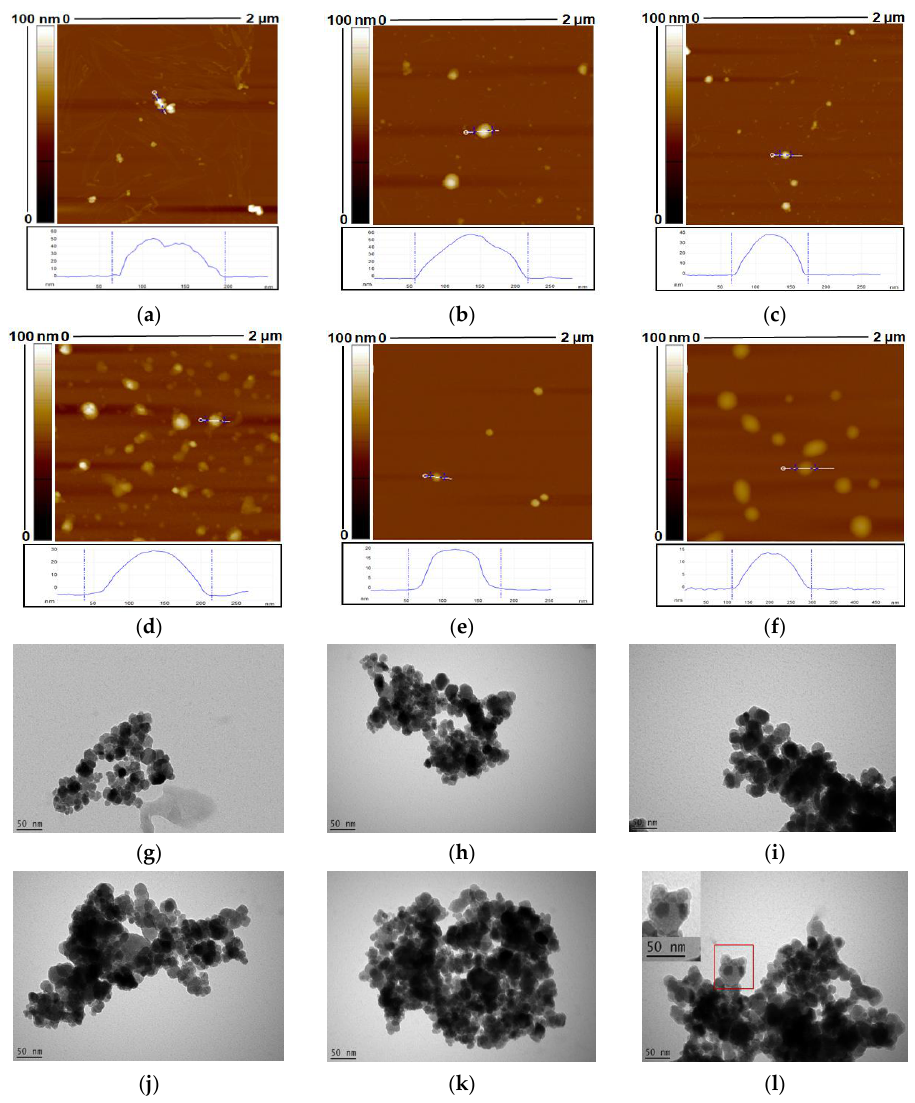
Figure 2. Atomic force microscopy (AFM) and transmission electron microscope (TEM) images of MAPs ( a , g ) and MACPs with the layer number of 1 ( b , h ), 4 ( c , i ), 5 ( d , j ), 8 ( e , k ) and 9 ( f , l ). Smaller particles were observed for MACPs with SA as the outermost